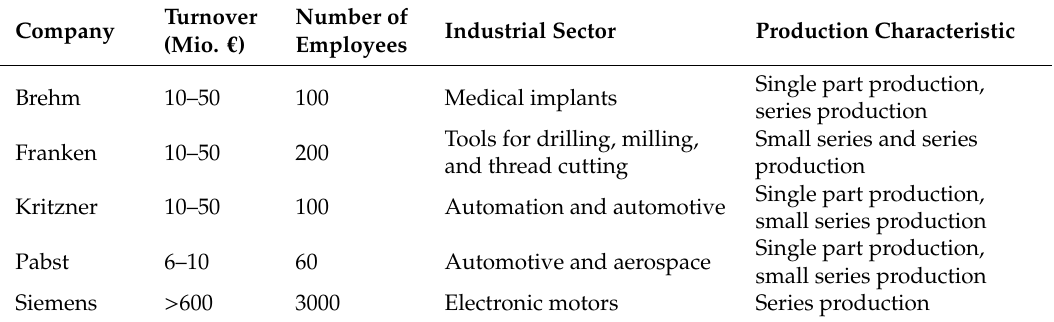
Table 1. Production oriented partners of the OBerA